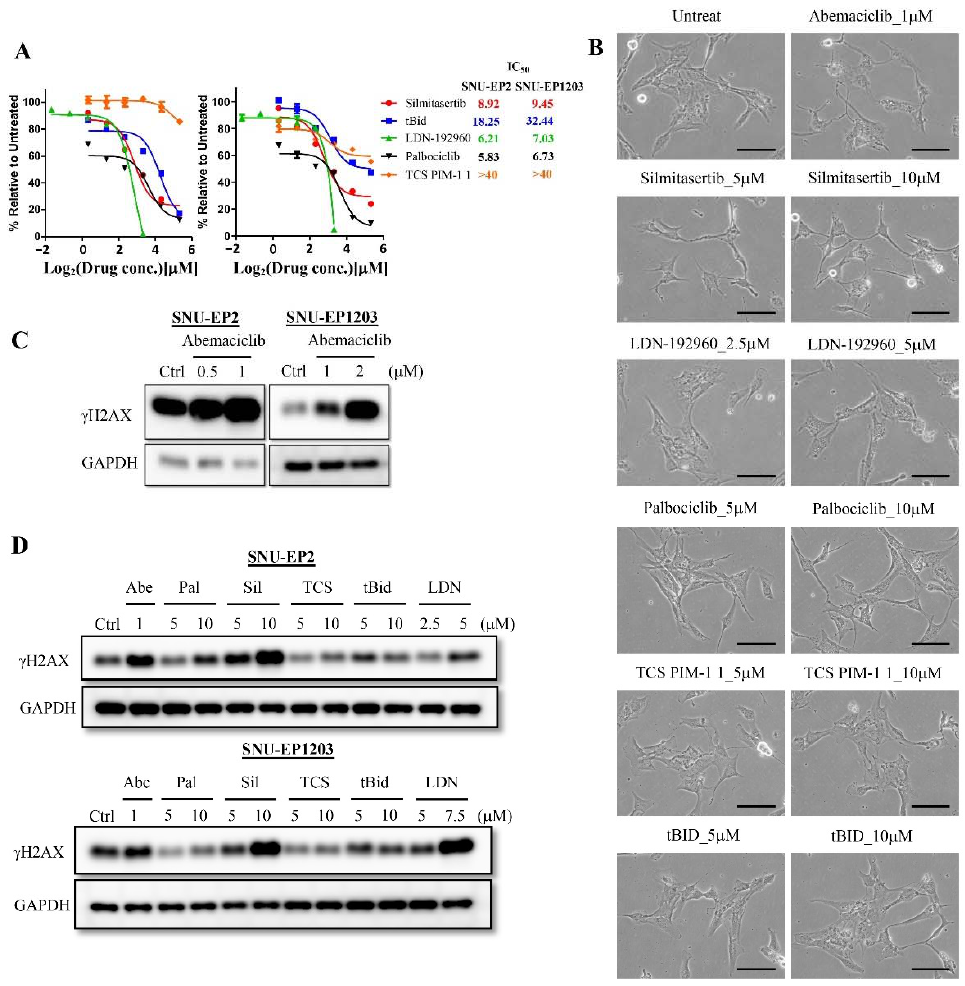
Figure 5. Abemaciclib treatment mediates morphological changes and γ H2AX expression through CK2 and DYRK2 in ependymoma cells. ( A ) SNU-EP2 and SNU-EP1203 were treated with specific inhibitors for 72 h and IC 50 values were evaluated by MTT assay. The IC 50 values are shown on the right side of the graph. ( B ) SNU-EP2 was exposed to the indicated concentrations of specific inhibitors for 24 h and morphology was examined by phase-contrast microscopy. Scale bar: 100 µ m. ( C ) SNU-EP2 and SNU-EP1203 were treated with di ff erent concentrations of abemaciclib for 72 h, and the levels of γ H2AX were detected via Western blot analysis. ( D ) SNU-EP2 and SNU-EP1203 were exposed to the indicated concentrations of specific inhibitors for 24 h, and the levels of γ H2AX were detected via Western blot analysis. Pal: palbociclib, Sil: silmitasertib, TCS: TCS PIM-1 1, LDN: LDN-192960.